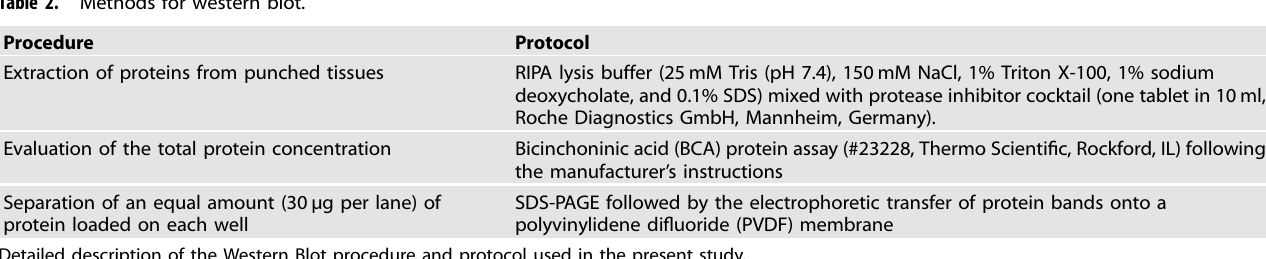
Table 2. Methods for western